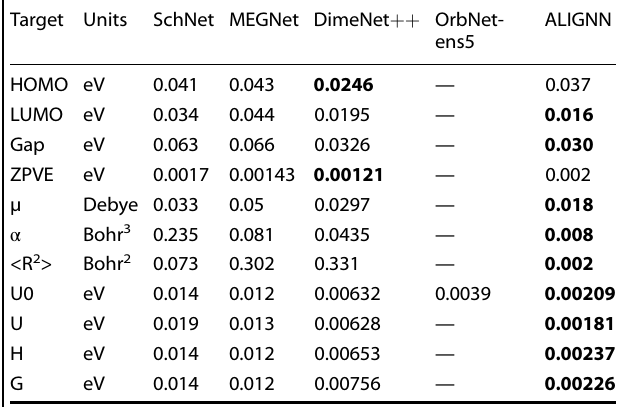
Table 5. Regression model performances on QM9 dataset for 11 properties using ALIGNN.